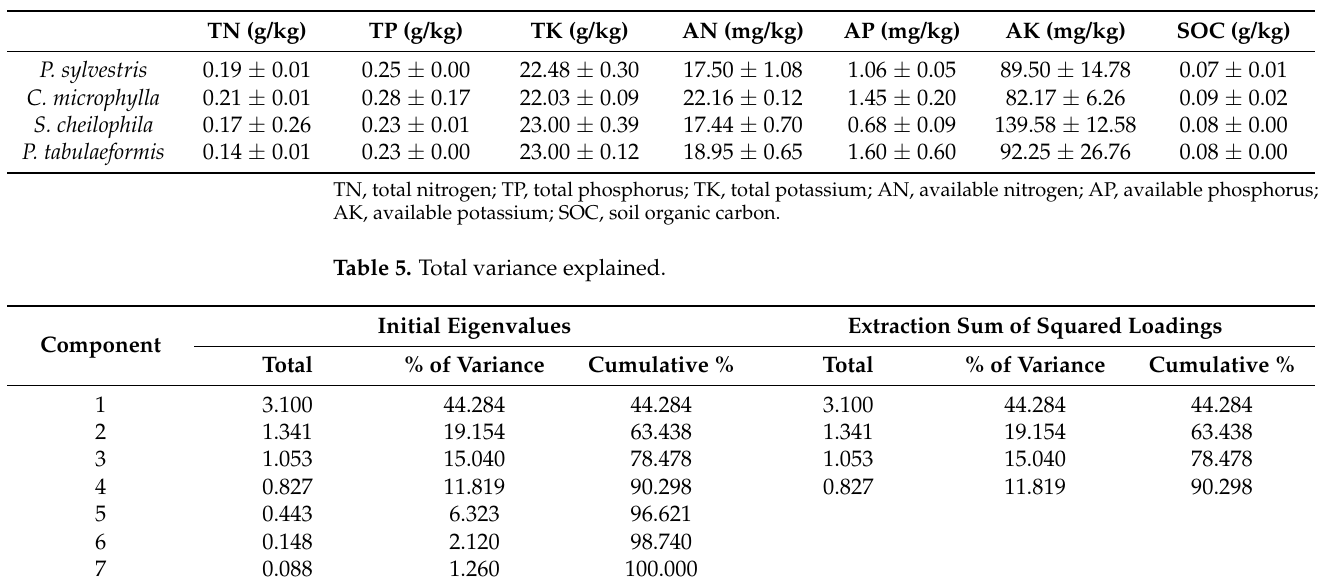
Table 4. Soil fertility characteristics of different vegetation types.